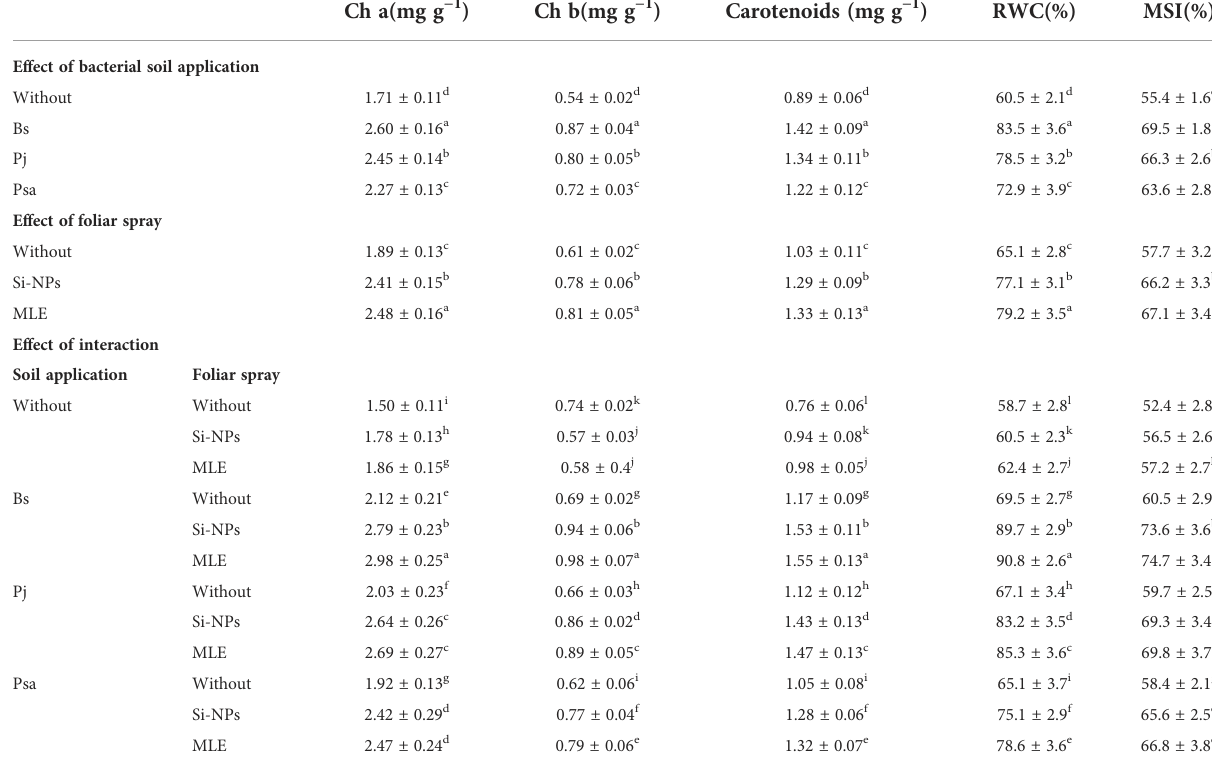
TABLE 4 Changes in photosynthetic pigments, relative water content (RWC), and membrane stability index (MSI) of heavy metal – stressed spinach plant in response to bioremediation of heavy metals bacterial applied as soil inoculation and/or foliar spray with MLE or